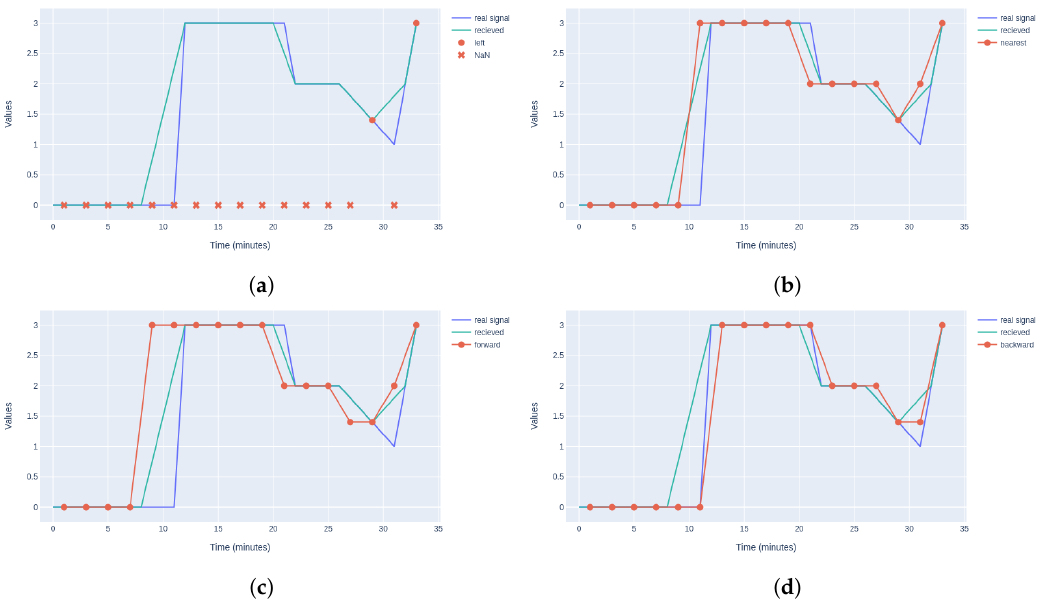
Figure 4. Application example results for different joining methods. ( a ) Left join. ( b ) Nearest join. ( c ) Forward join. ( d ) Backward join. Table 6. Error values for different join methods in the application